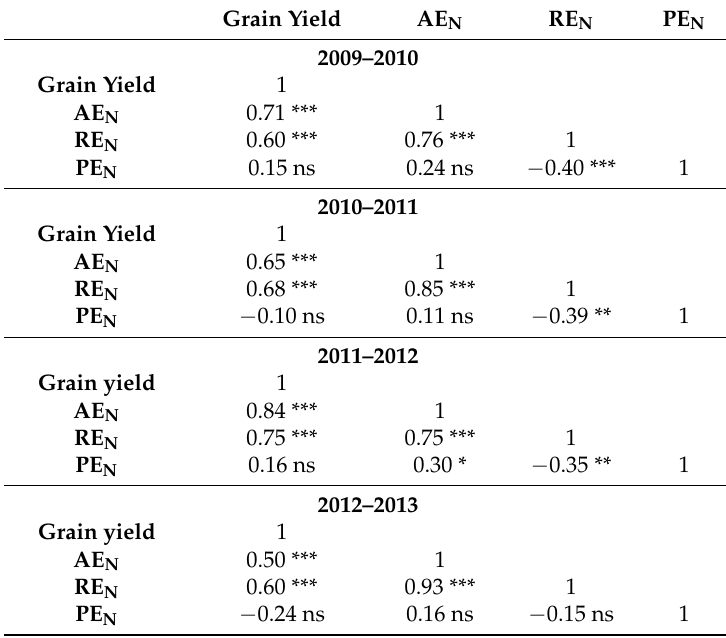
Table 8. Correlation coefficients between wheat yields and NUE parameters: AE N , RE N , and PE N in four cycles, as influenced by selected treatments composed of urea sources, timing and methods of fertilizer application at the International Maize and Wheat Improvement Center (CIMMYT), in the Yaqui valley, near Ciudad Obregon, Sonora, Mexico. Grain